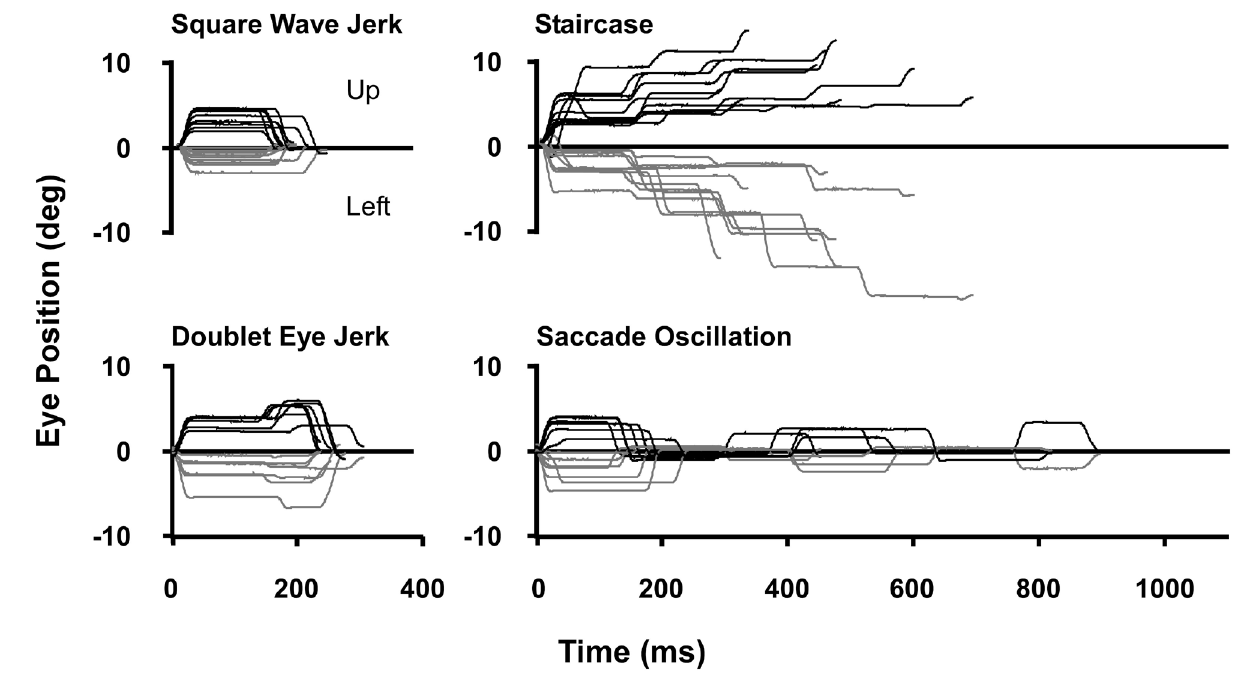
Figure 1. The four types of eye movements evoked by the lesion through the superior colliculus commissure and right rostral-medial superior colliculus. Grey traces show the horizontal component (Left) and black traces the vertical component (Up) of representative irrepressible saccades collected on the third post-discovery